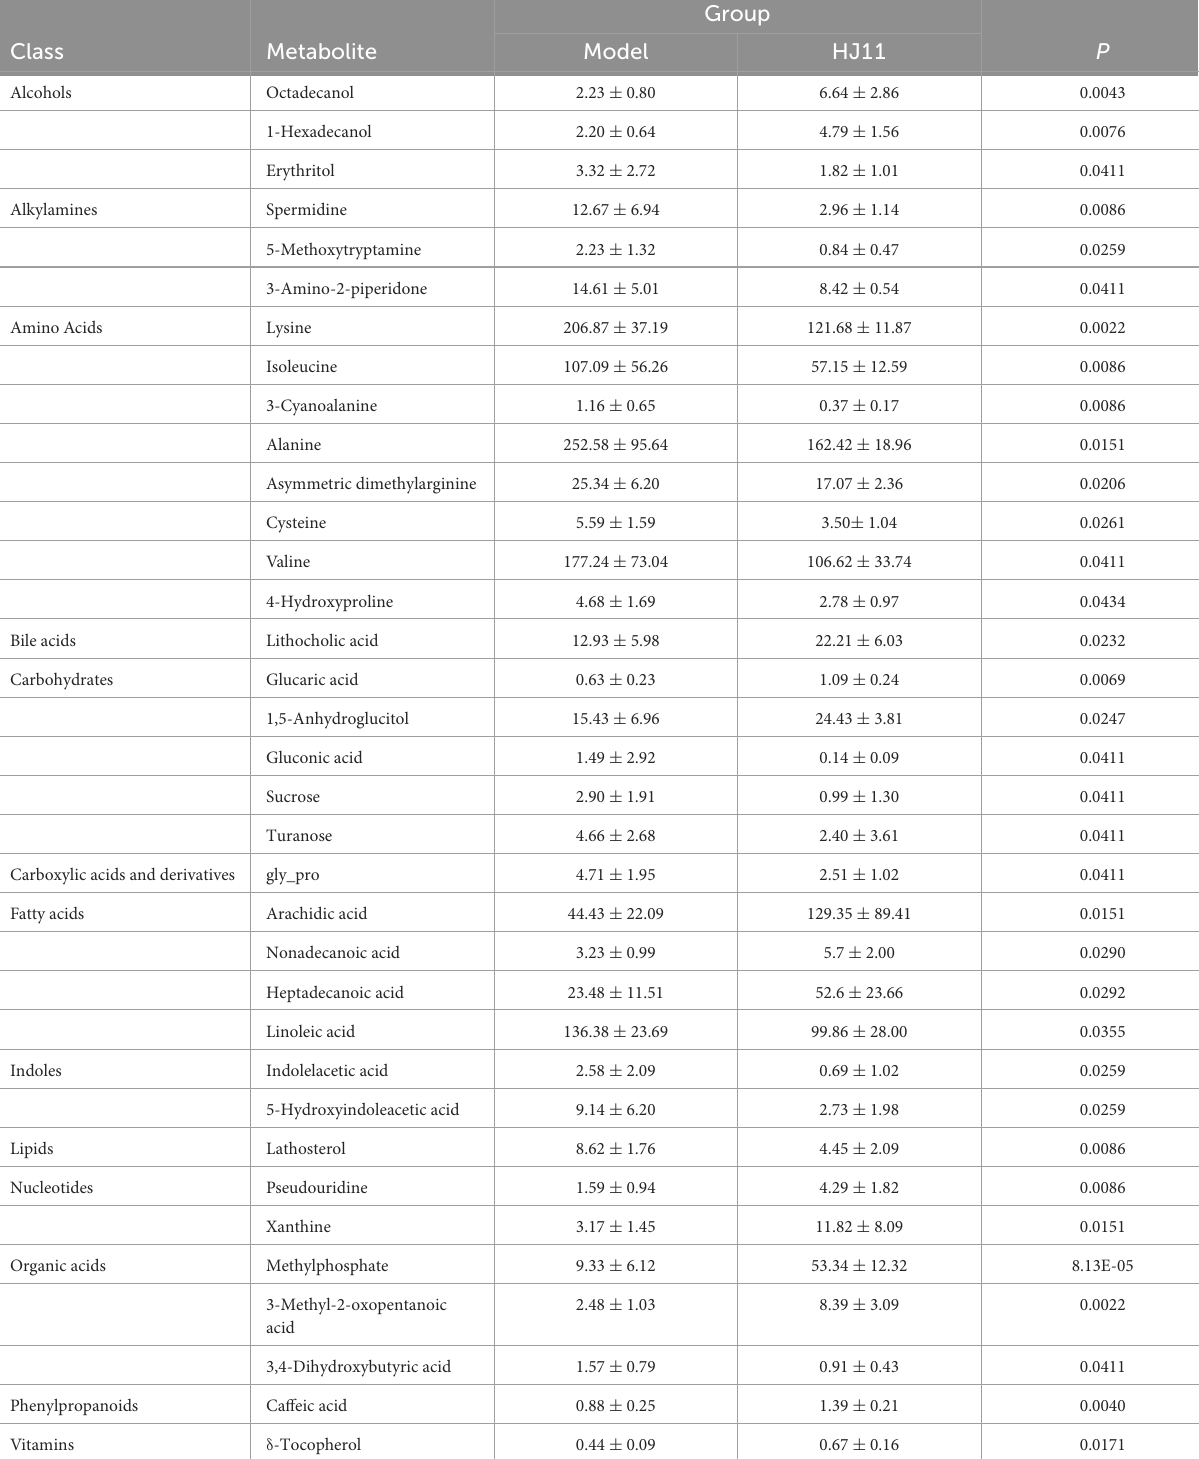
TABLE 2 Differentially expressed metabolites between the model and HJ11